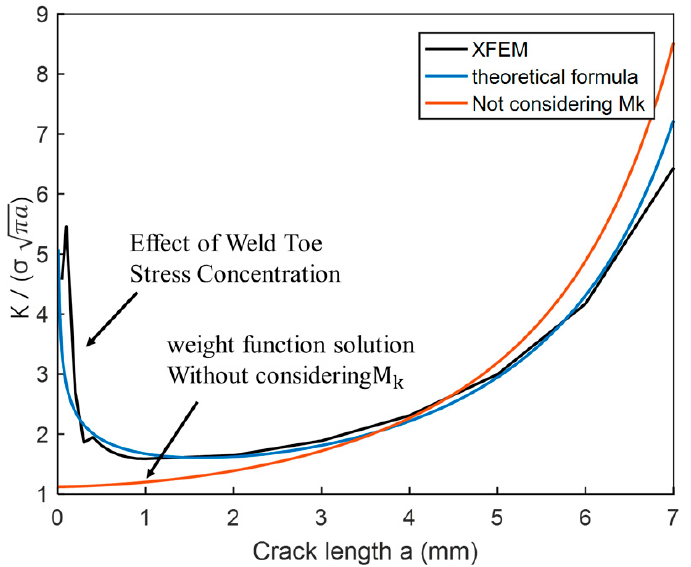
and XFEM (cid:3038)